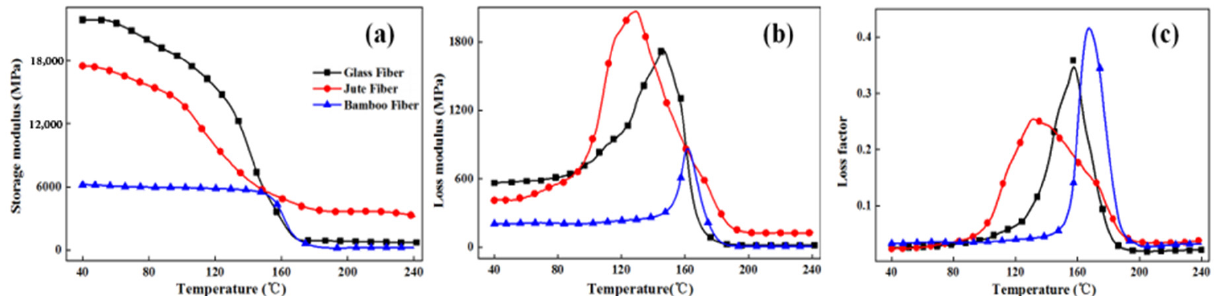
Figure 8. Thermodynamic mechanical performances of circumferential composites at single frequency: ( a ), Storage modulus; ( b ), Loss modulus; ( c ), Loss factor.